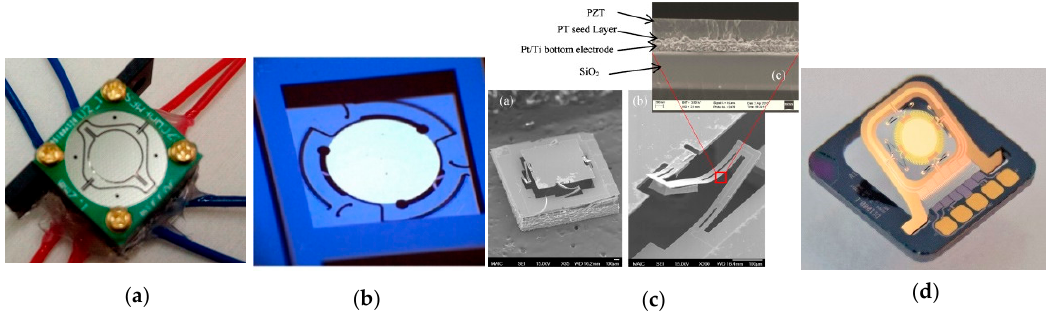
Figure 11. High FoM double resonant scanning MEMS mirrors. ( a ) Electromagnetic actuation [81]; ( b ) Electrostatic actuation [78]; ( c ) Piezoelectric actuation [95] ( d ) Electrothermal actuation [90].